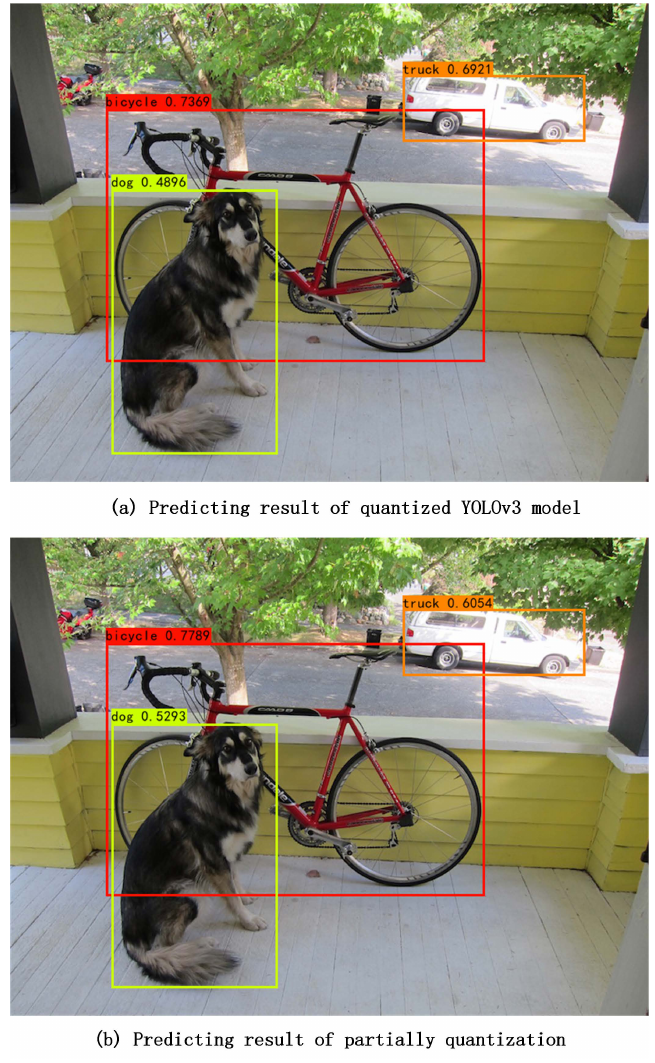
Figure 8. Comparison of predicting results between the fully quantized model and the partially quantized